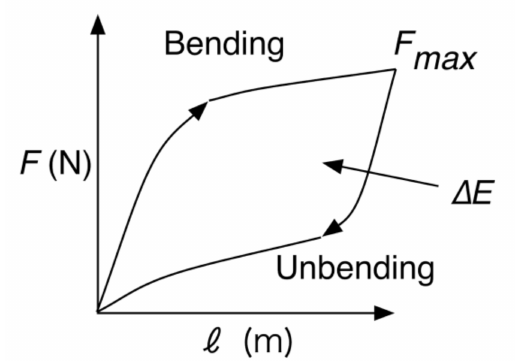
Figure 4. After the line segment length has been calculated from the angle, the hysteresis plot of F bending ( (cid:96) ) and F unbending ( (cid:96) ) can be created, and the total change in energy can be calculated from the di ff erence of the integrals of the two